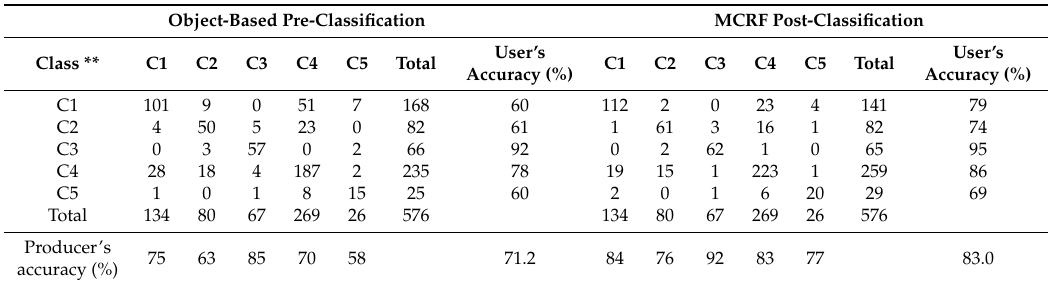
Figure 7. Land use/cover classification results for the Maanshan study area: ( a ) pre-classification map; ( b ) MCRF post-classification map. Table 5. Accuracy assessment for pre-classification and corresponding SS-coMCRF post-classification for the Maanshan study